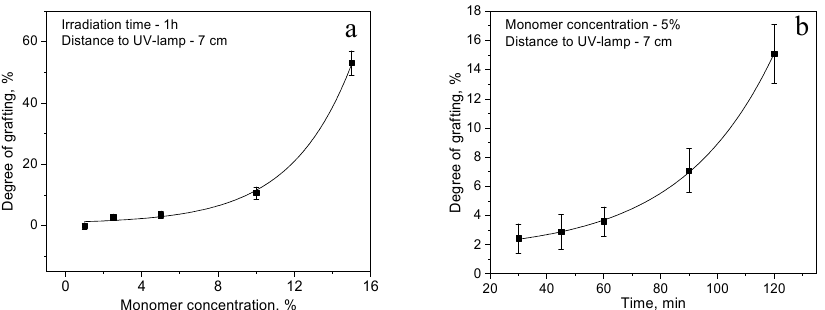
Figure 2. Effect of monomer concentration ( a ) and time of UV irradiation ( b ) on the degree of grafting on PET TeMs (pore diameter of initial PET TeMs is 350 nm, pore density is 1 × 10 8 pore/cm 2 ).